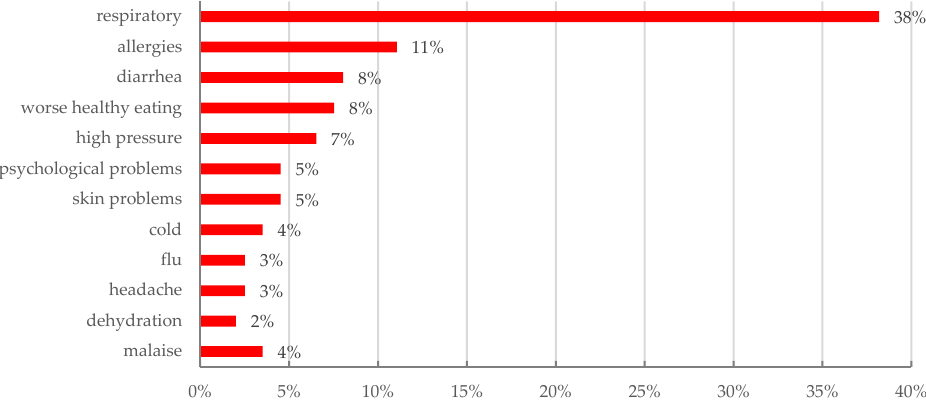
Figure 8. Perception of the main health impacts related to drought (Source: prepared by the authors).